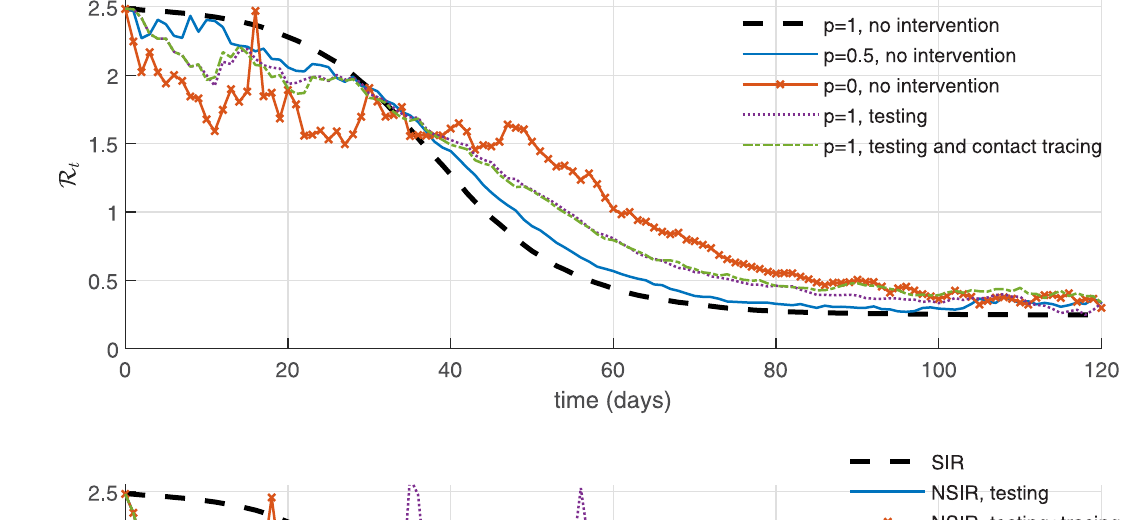
Fig 11. NSIR model—effective reproduction number R